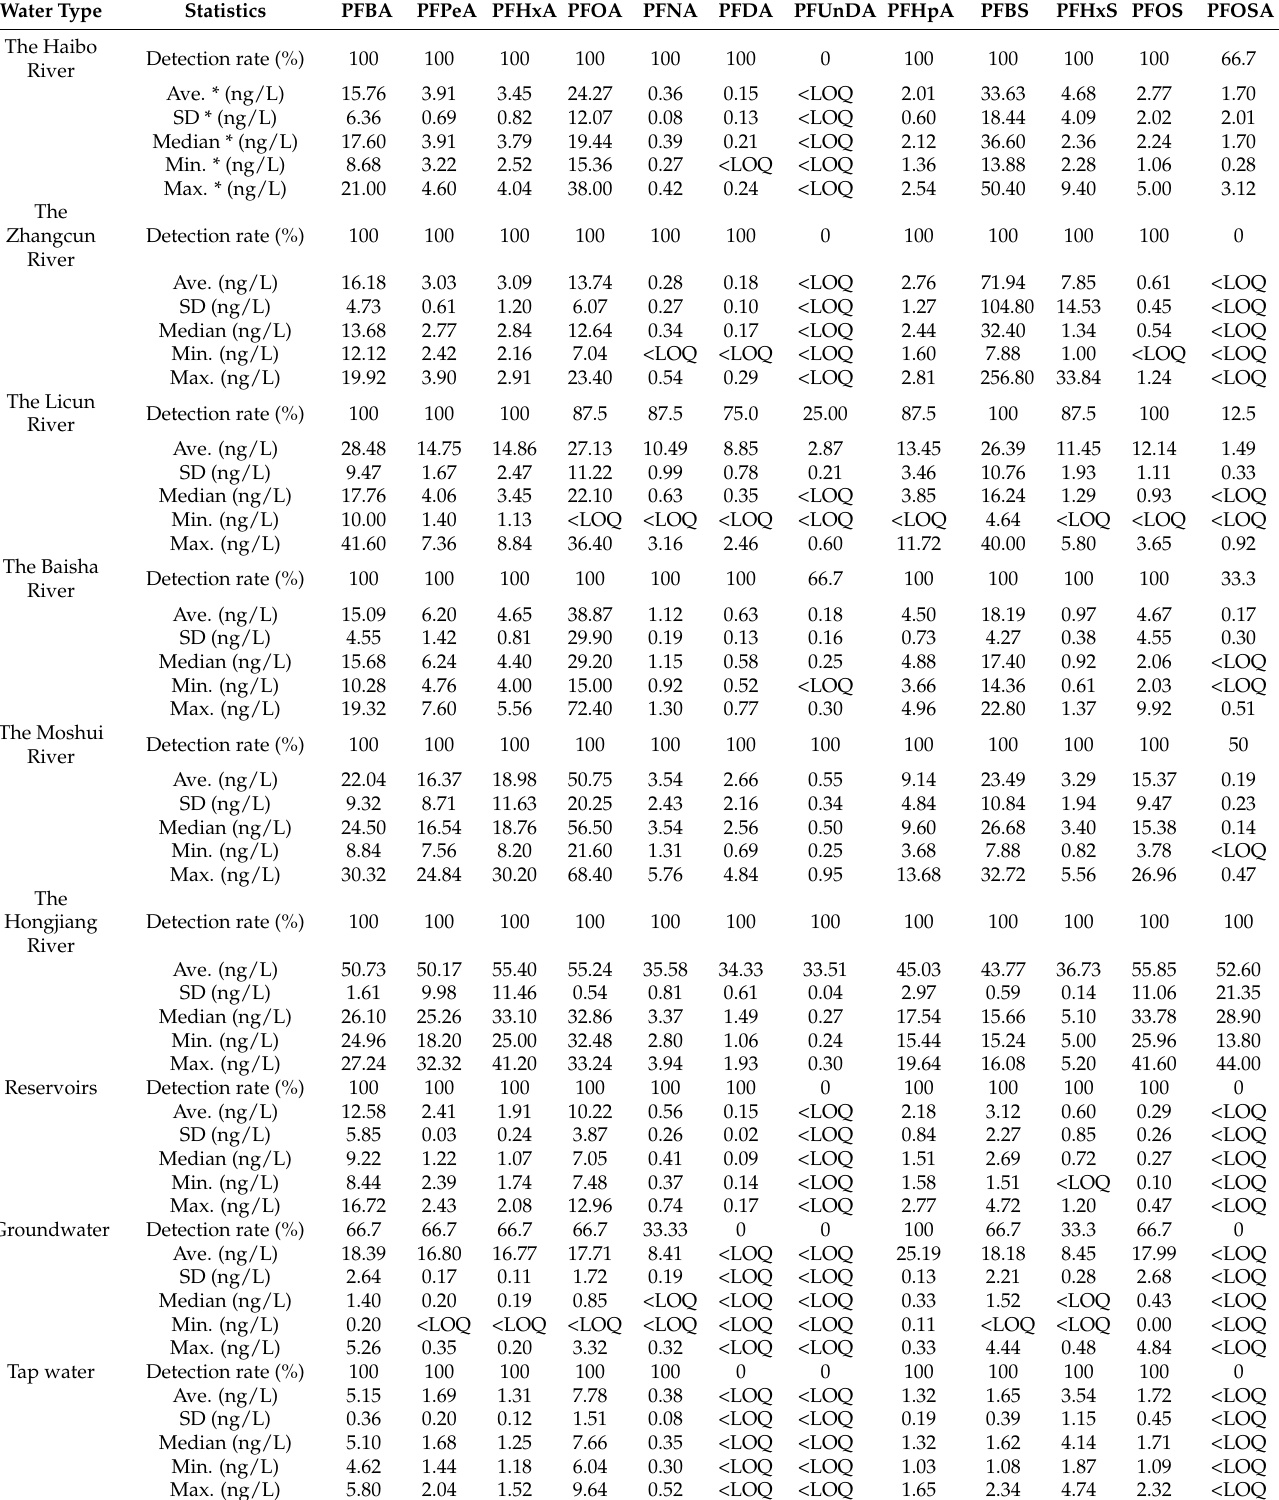
Table 1. Statistics on the detected PFASs in water samples from the rivers, the drinking water sources, and drinking waters in